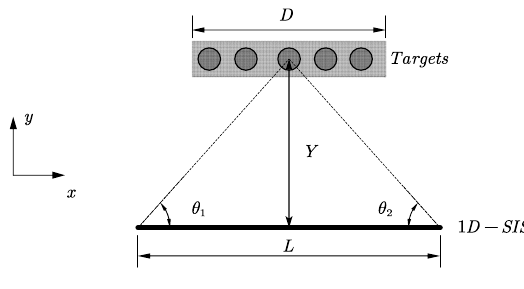
Figure 1. The observation scenario.